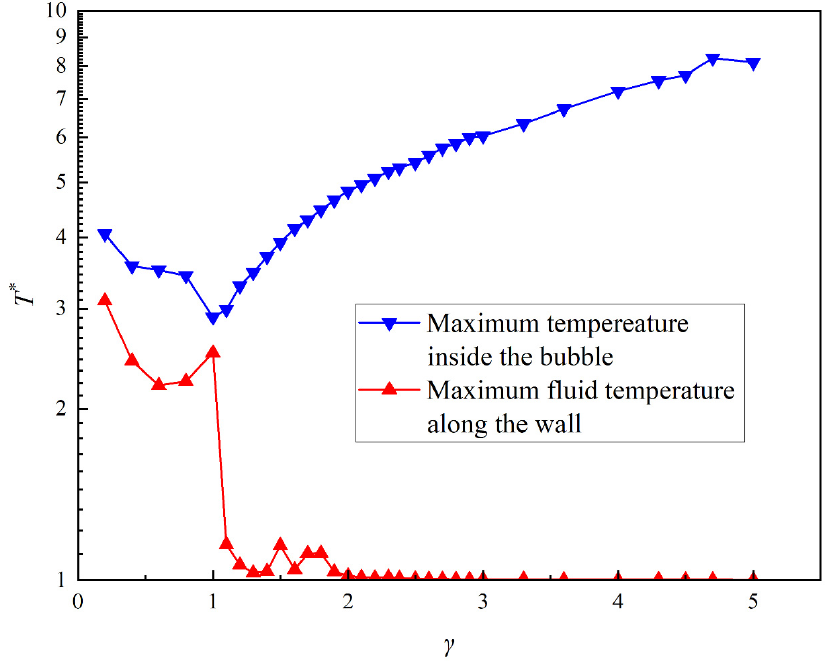
Figure 9. The maximum temperature inside the bubble and the maximum fluid temperature along the wall under different γ values. the wall under different γ